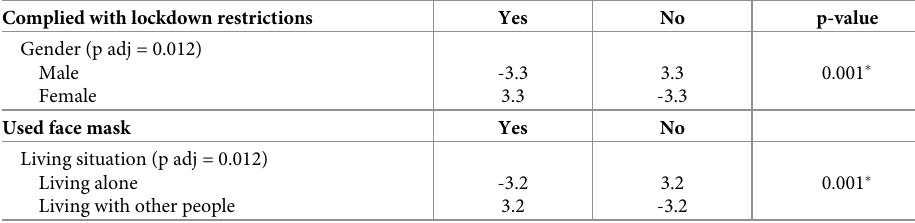
Table 4b. Post-hoc adjusted residuals for preventive behaviours with Bonferroni